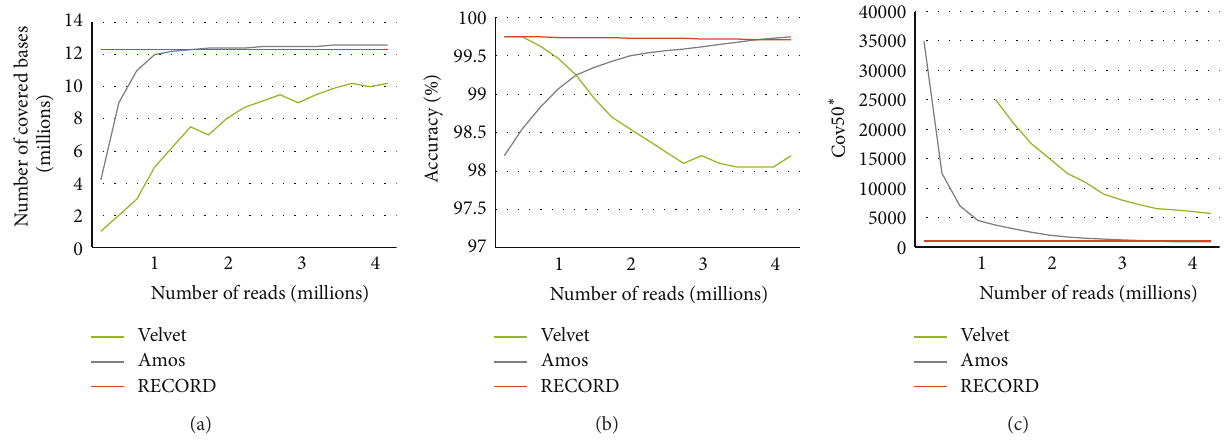
Figure 6: Comparison of the proposed approach (RECORD) with two state-of-the-art genome assemblers on real data. In this experiment, we compared assemblies resulting from various number of experimental reads to the assembly which is produced by Amos using all the experimental reads; that is, the target genome is the assembly produced by Amos using all the reads. In this case, the reference genome exhibits 99.7 percent identity with the result of Amos which is used as the gold standard. The diagrams follow the same structure as the one in Figure 4.